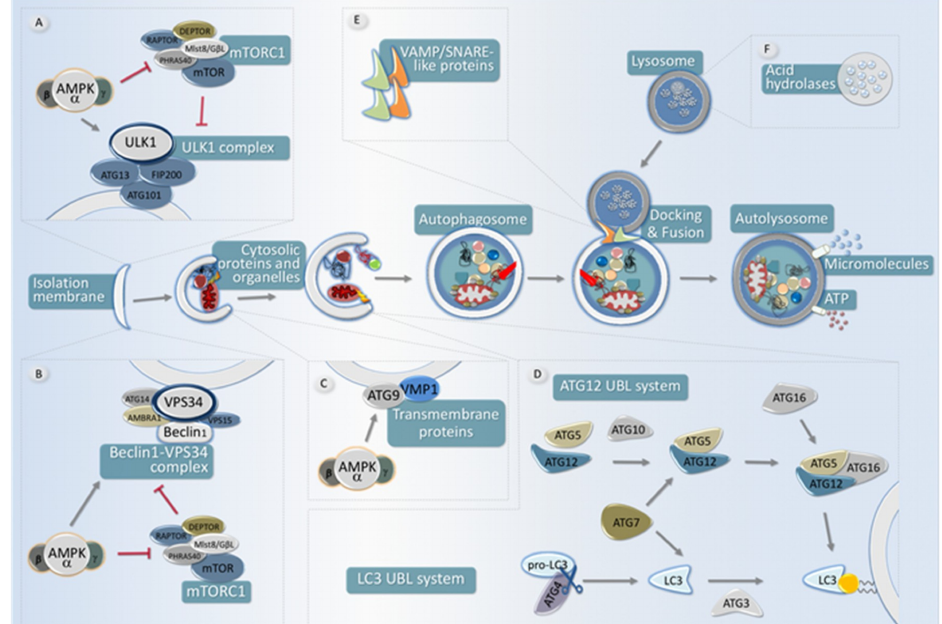
Figure 3. Scheme of the main steps for autophagy and their regulation by AMPK. An autophagy pathway starts with the formation of the isolation membrane, also known as